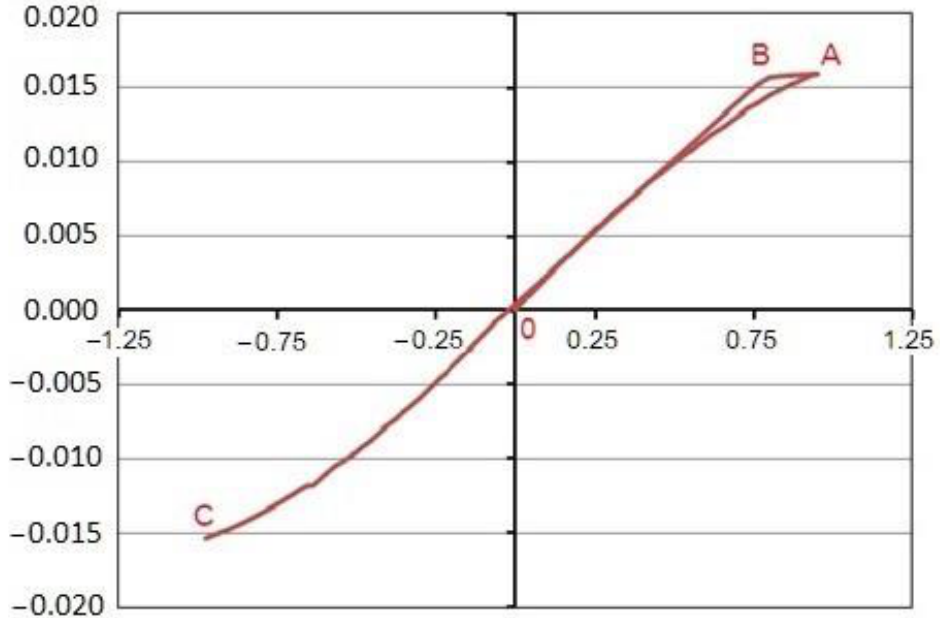
Figure 17. Kinematic error of the circular spline in reversing motion relative to the angle of rotation of a cam generator.